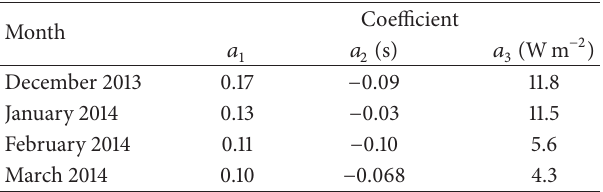
Table 2: Monthly coefficients of the OHM applied to the EACF